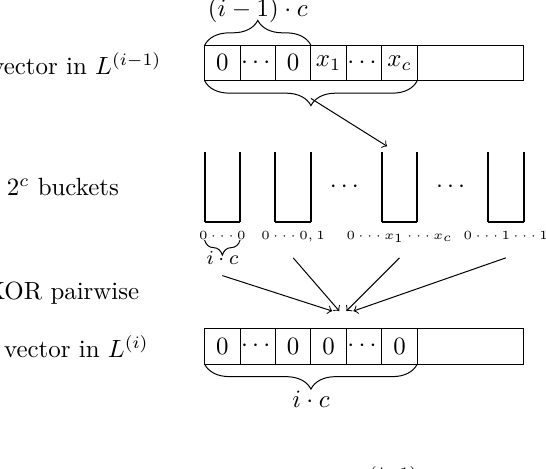
Figure 1: Combine for L ( i − 1) .